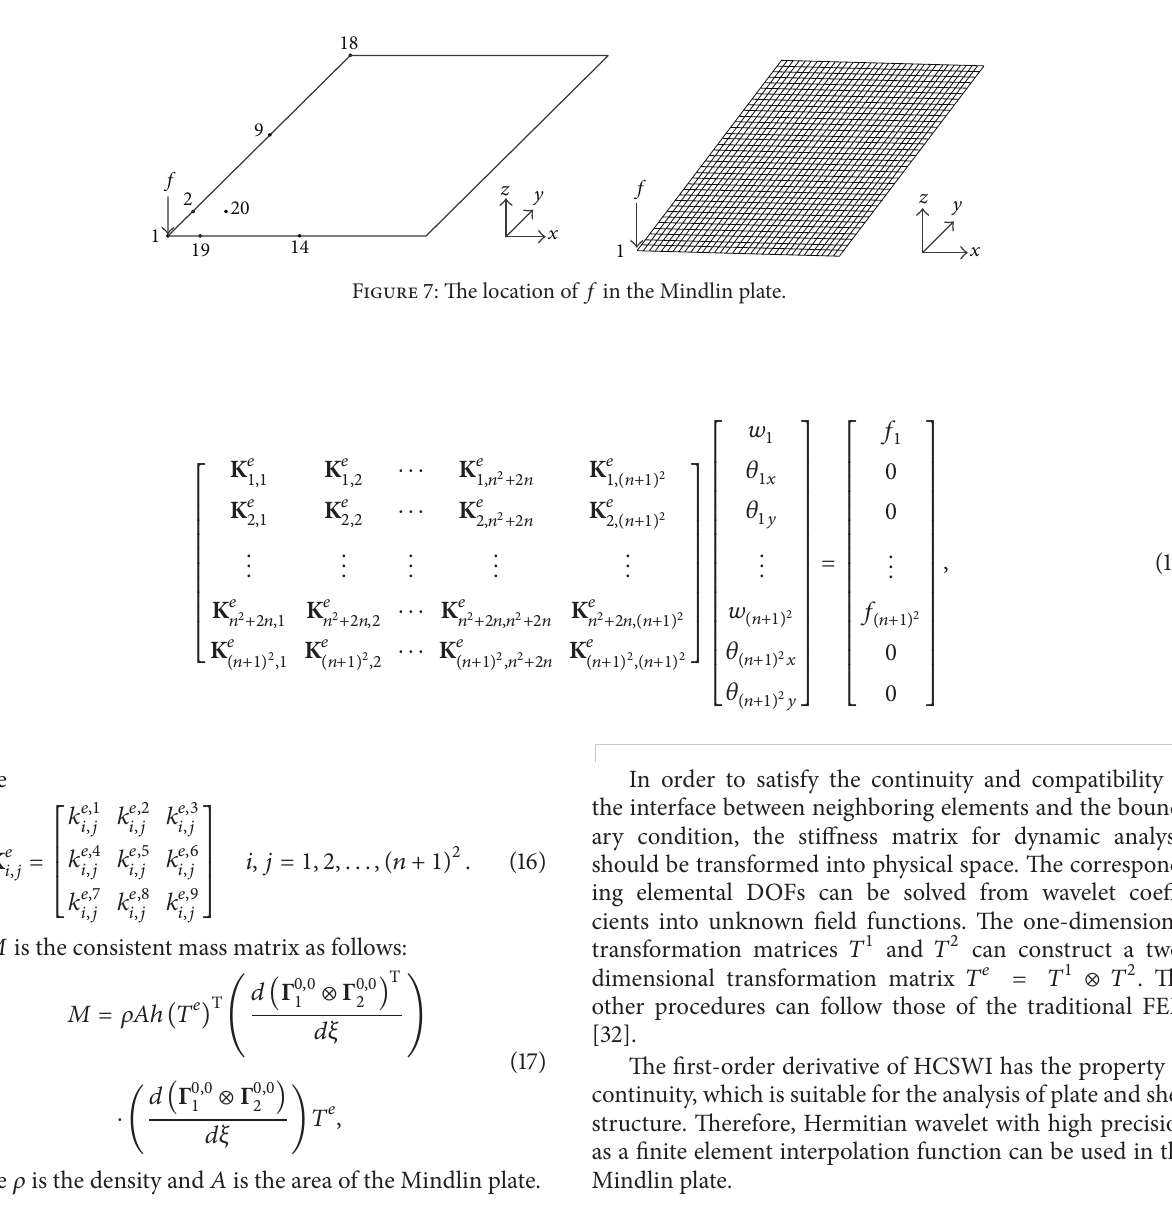
Figure 6: The 35 × 35 mesh of the Mindlin plate.